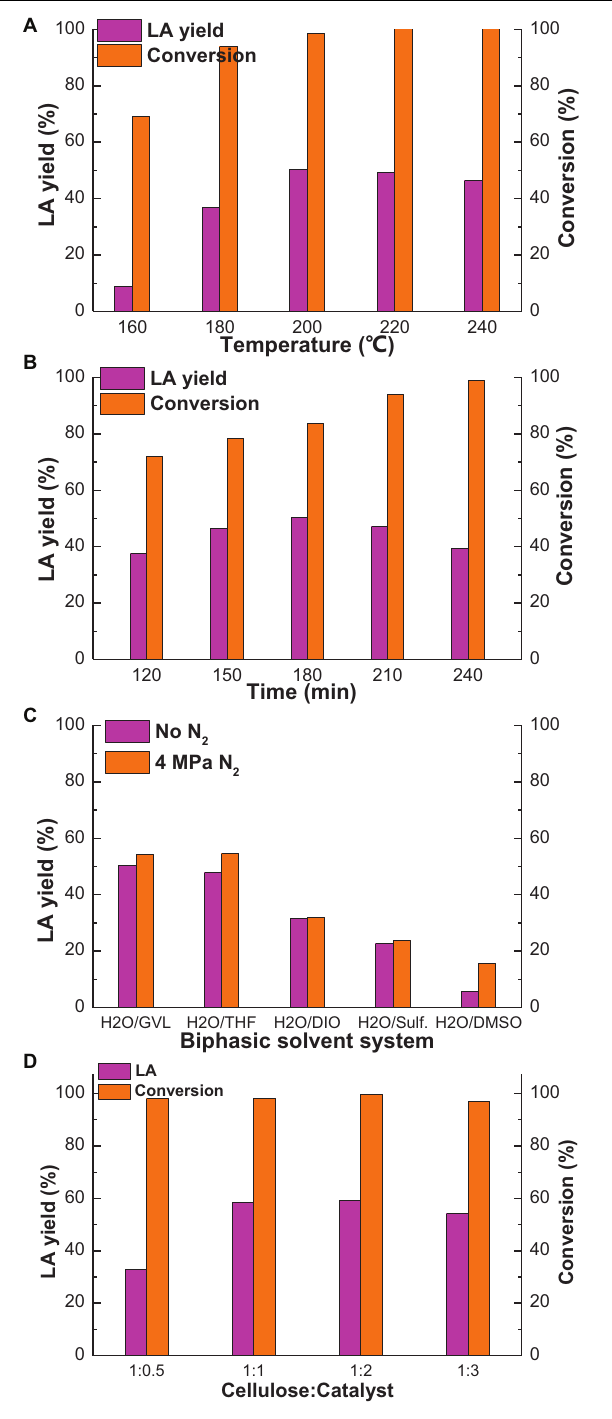
FIGURE 1 | Effect of reaction temperature (A) , reaction time (B) in GVL/H 2 O, N 2 pressure (C) and catalyst loading (D) on cellulose conversion. Reaction condition: (A) cellulose 100 mg, Amberlyst-15 300 mg, H 2 O 6 mL, GVL 6 mL, 180 min; (B) cellulose 100 mg, Amberlyst-15 300 mg, H 2 O 6 mL, GVL 6 mL, 200 ◦ C; (C) cellulose 100 mg, Amberlyst-15 300 mg, 180 min, 200 ◦ C, ratio of biphasic solvent: 1:1, 4 MPaN 2 ; (D) cellulose 100 mg, H 2 O 6 mL, GVL 6 mL, 180 min, 200 ◦ C, 4 MPaN 2